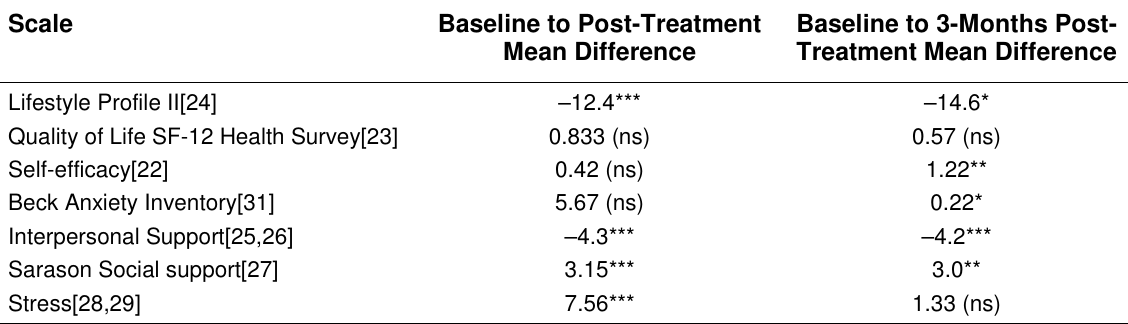
Selected Measurements Utilized in the Panchakarma